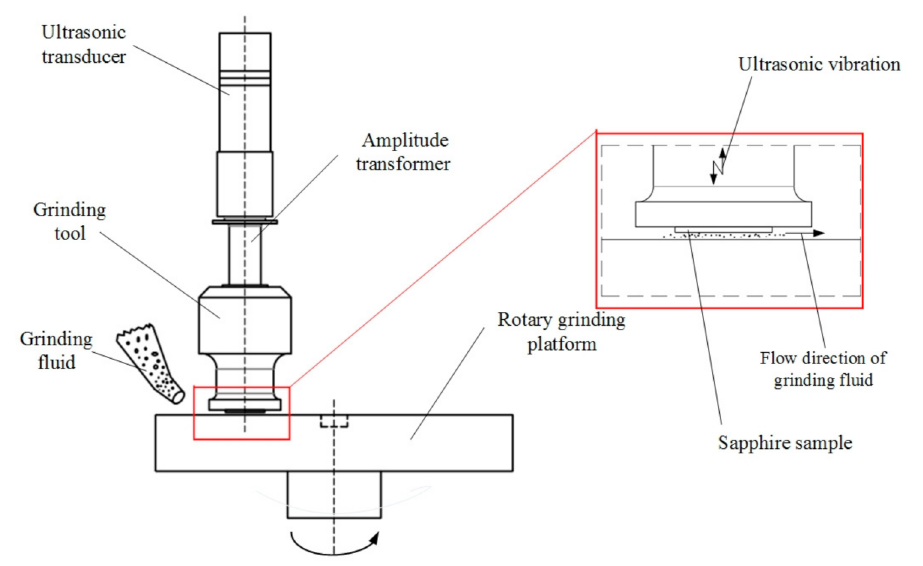
Figure 1. Schematic diagram of non-contact ultrasonic grinding